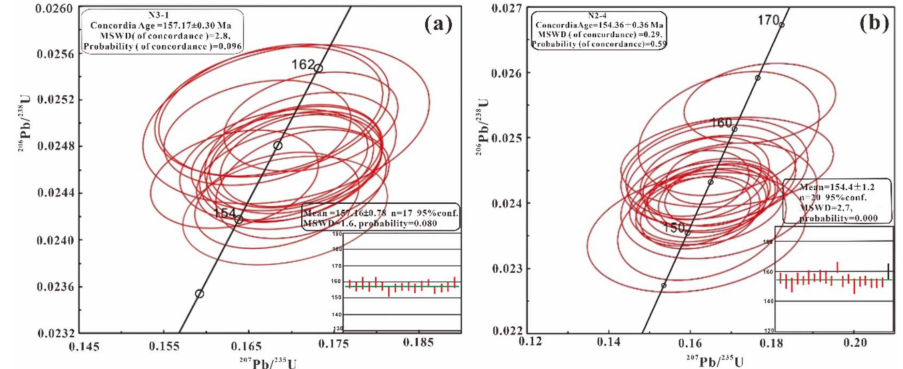
Figure 5. U-Pb concordia diagrams showing the LA-ICP-MS zircon dating results of the Nianzigou monzogranite ( a ), and granite porphyry ( b ).